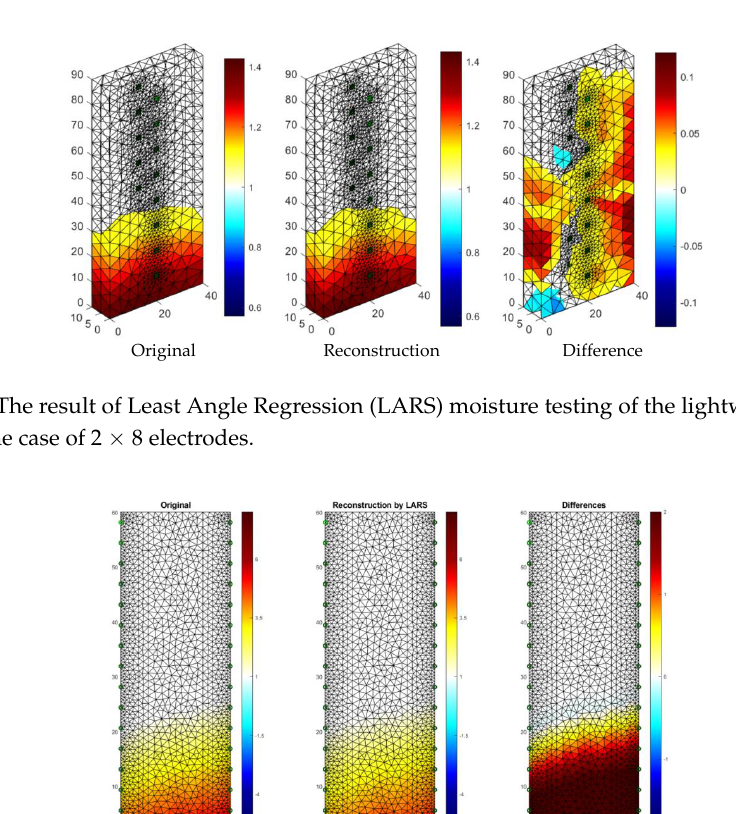
Figure 17. The result of ElasticNet moisture testing of the lightweight concrete block for the case of 2 × 8 electrodes.